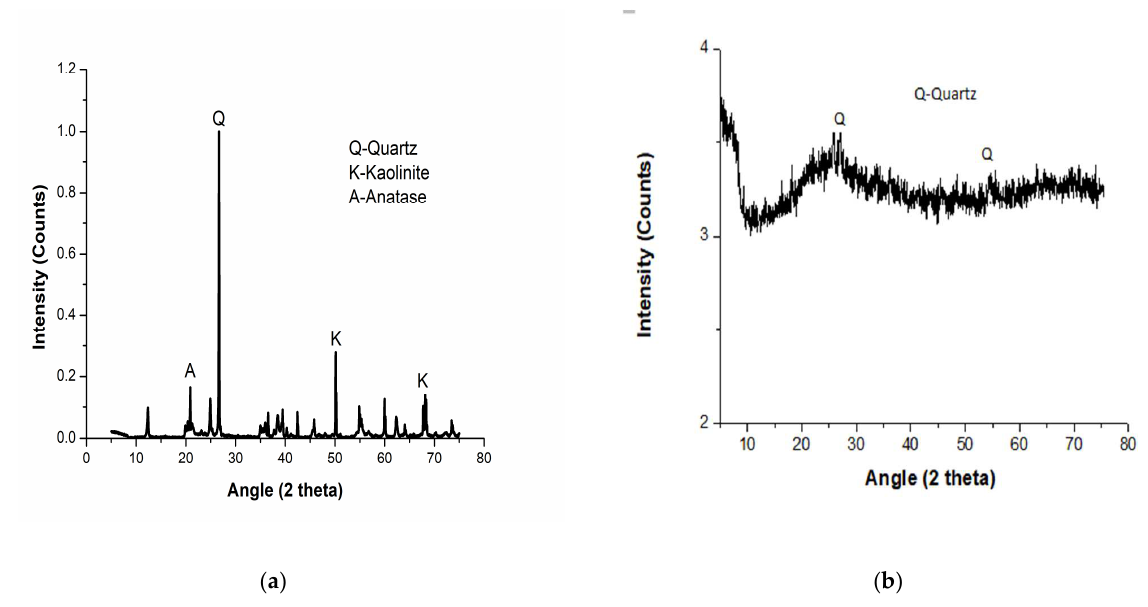
Figure 7. XRD patterns of the ( a ) kaolin and ( b ) metakaolin samples. Table 3. Crystalline phases of